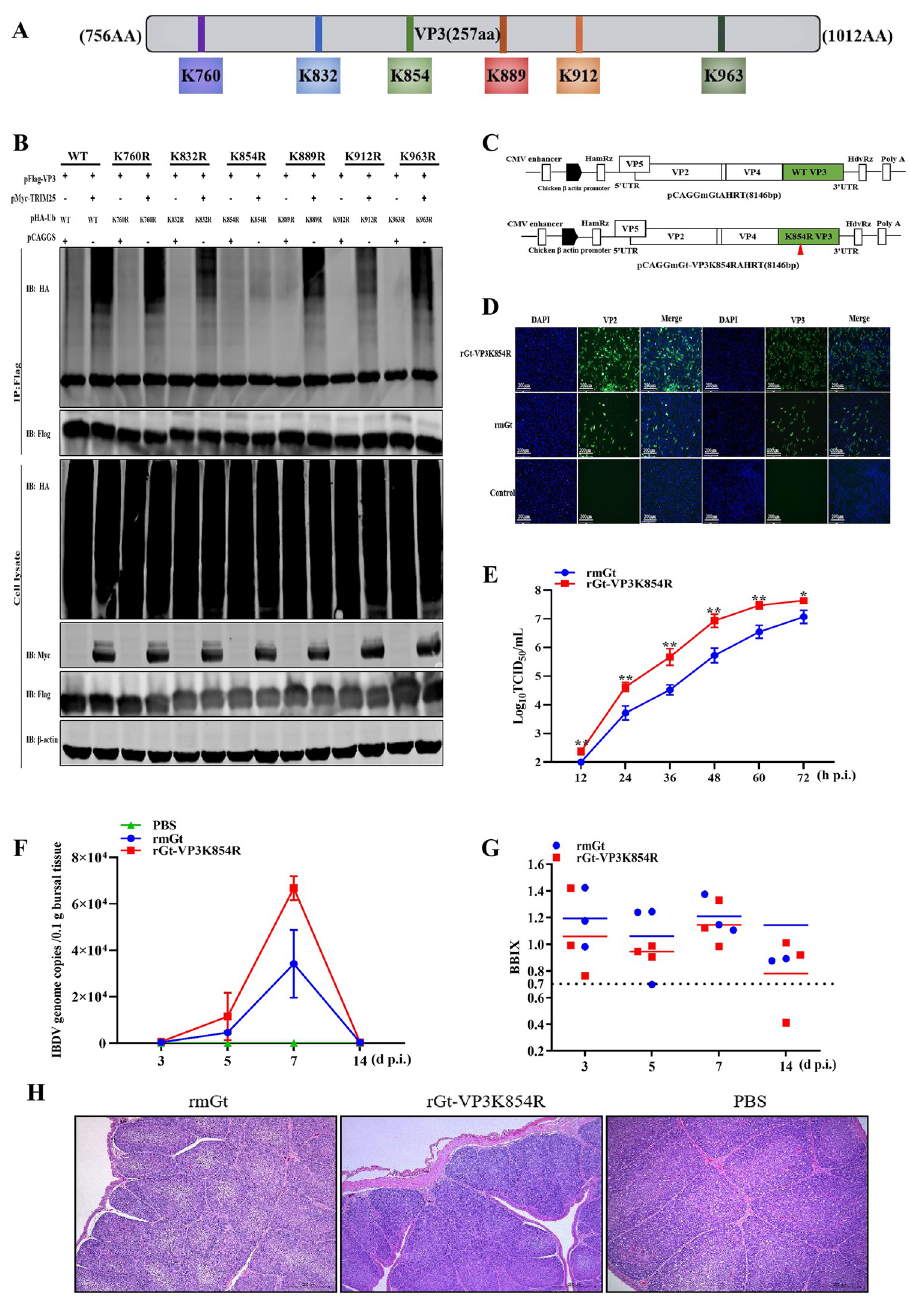
Fig 7. Lys854 of VP3 is a ubiquitination site of TRIM25. (A) Schematic representation of the possible ubiquitination site of VP3. (B) The amino acid of VP3 was ubiquitinated by TRIM25. Different VP3 plasmids (WT and different mutants) and pHA-Ub were co-transfected with pMyc-TRIM25 for 36 h. Then, the lysates were analyzed by immunoblotting. (C) Schematic representation of the strategy of rescuing IBDV. Segments A and B were constructed according to the instruction in the Materials and methods section. (D) IFA assay. DF-1 cells were infected with rmGt and rGt-VP3K854R viruses and were detected with anti-VP2/VP3 mAb. (E) Replication activity between rmGt and rGt-VP3K854R was detected using a TCID 50 assay in vitro . CEFs were infected with WT and mutant IBDV at the MOI of 0.01 for 12, 24, 36, 48, 60, and 72 h. The 3-week-old SPF chickens were challenged with 10 5.8 TCID 50 /200 μ L of two viruses, and bursae samples were collected at3, 5, 7, and 14 d p.i. (F) IBDV genome copies of rmGt and rGt-VP3K854R were detected by RT-qPCR in vivo . (G) BBIX of all challenged bursae. (H) Histopathological examination of bursae at 7 day p.c. Three independent experiments were performed, and data are shown as mean ± standard deviations for triplicates from a representative experiment. � , P < 0.05; �� , P < 0.01.